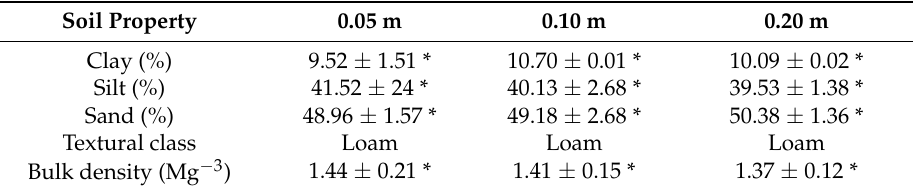
Figure 5. Calibration relationships between soil water content (measured from the 5TE sensors installed near the reference cable locations in the field) and T cum _ N (thermal response measured by the DTS instrument at corresponding cable locations), ( a ) single calibration including all three depths; ( b ) depth 0.05 m; ( c ) 0.1 m and ( d ) 0.20 m depths, respectively. Table 2. Measured soil properties in the study area at reference locations at